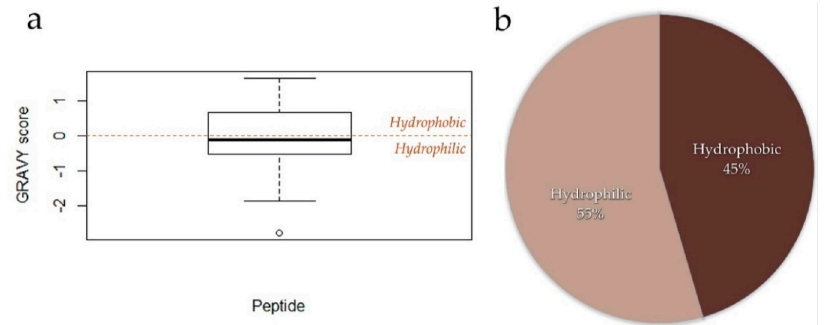
Figure 3. Hydrophobicity analysis of the 22 peptides discussed in this manuscript. ( a ). Boxplot of the Grand average of hydropathicity index (GRAVY) values of these peptides calculated through the Protein GRAVY website (https://www.bioinformatics.org/sms2/protein_gravy.html accessed on 11 February 2021) [355] and visualized using RStudio version 1.1.456 (Rstudio, Boston, MA, USA). GRAVY scores greater than 0 are considered hydrophobic while scores less than 0 are consid- ered hydrophilic [354,356] as demarcated by the brown, dashed, horizontal line. ( b ) Proportion of the 22 peptides classified based on their hydrophobicity GRAVY